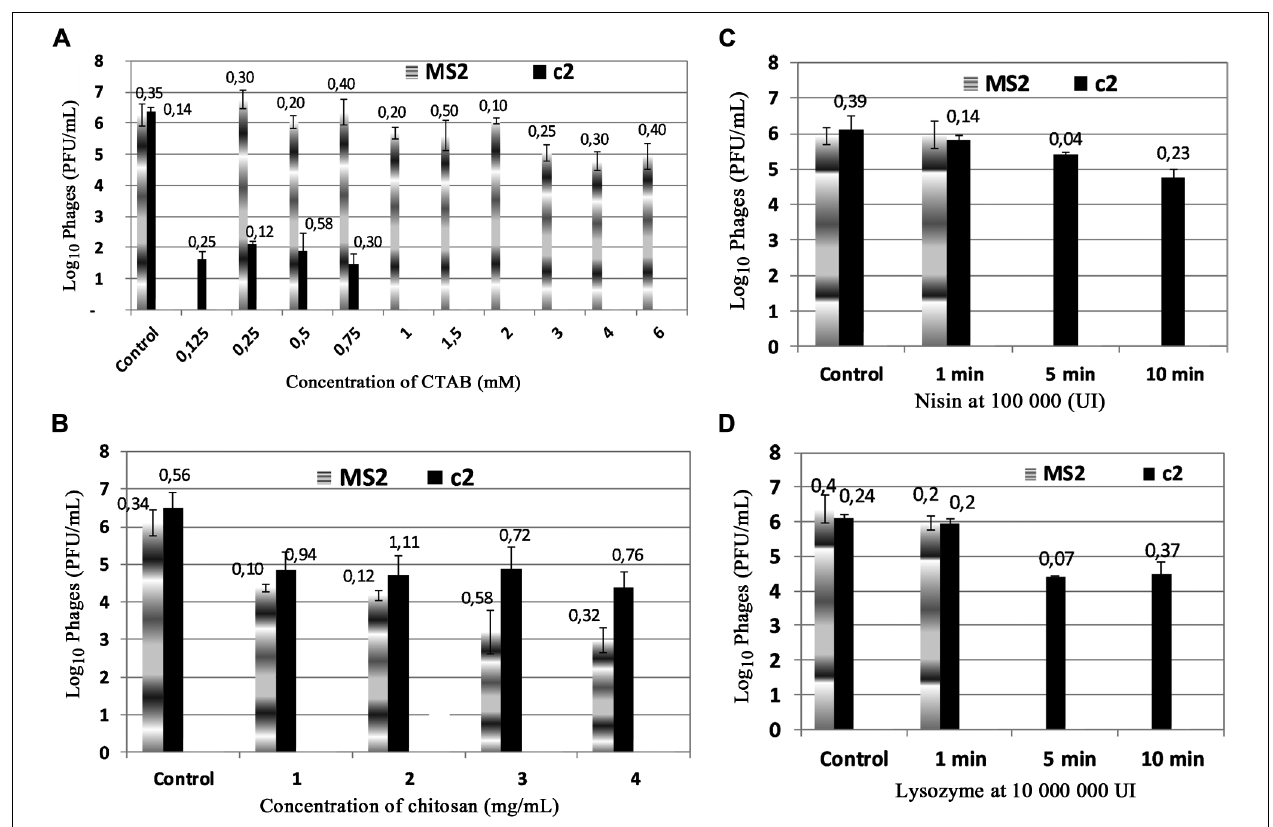
FIGURE 1 |Antiviral activities of cationic antimicrobial compounds on bacteriophages c2 and MS2: (A) CTAB; (B) chitosan; (C) nisin, and (D) – lysozyme. The phages were incubated at room temperature for 1 min and enumerated by the double layer method. Control without antimicrobial compound.Value of ± SD is on the top of